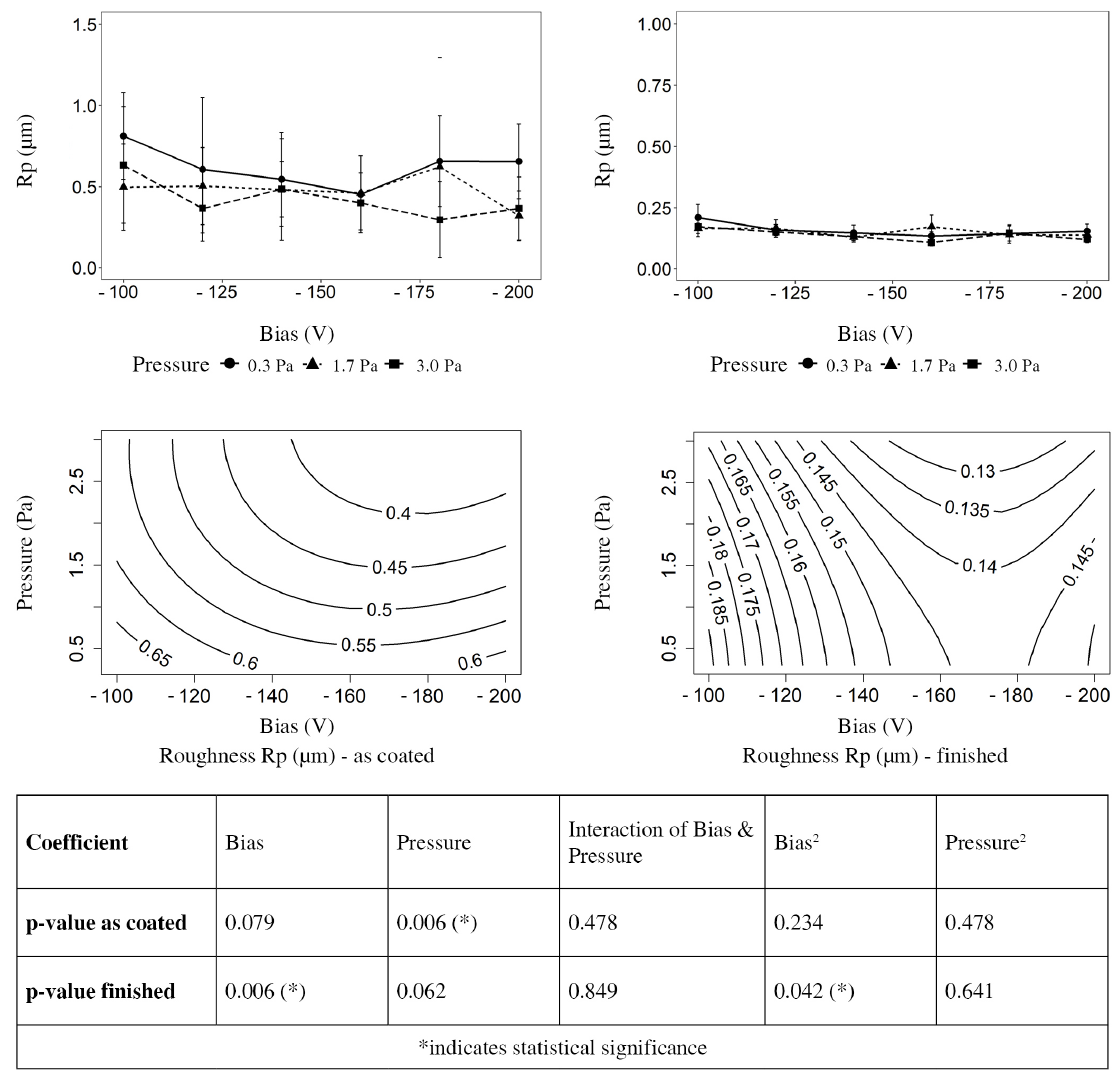
Figure 4. Scatter plots and response surface of the line roughness Rp as coated and finished.